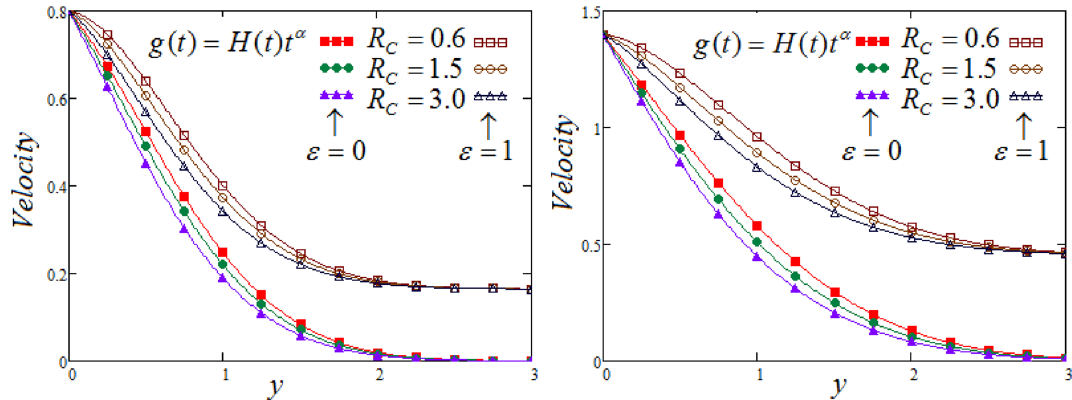
Figure 5. Representation of fluid velocity v ( y , t ) against y for distinct values of Rc with N = 2.5, Pr eff = 4.5, Sc = 0.8, (cid:31) 1 = 0.7, ℘ = π